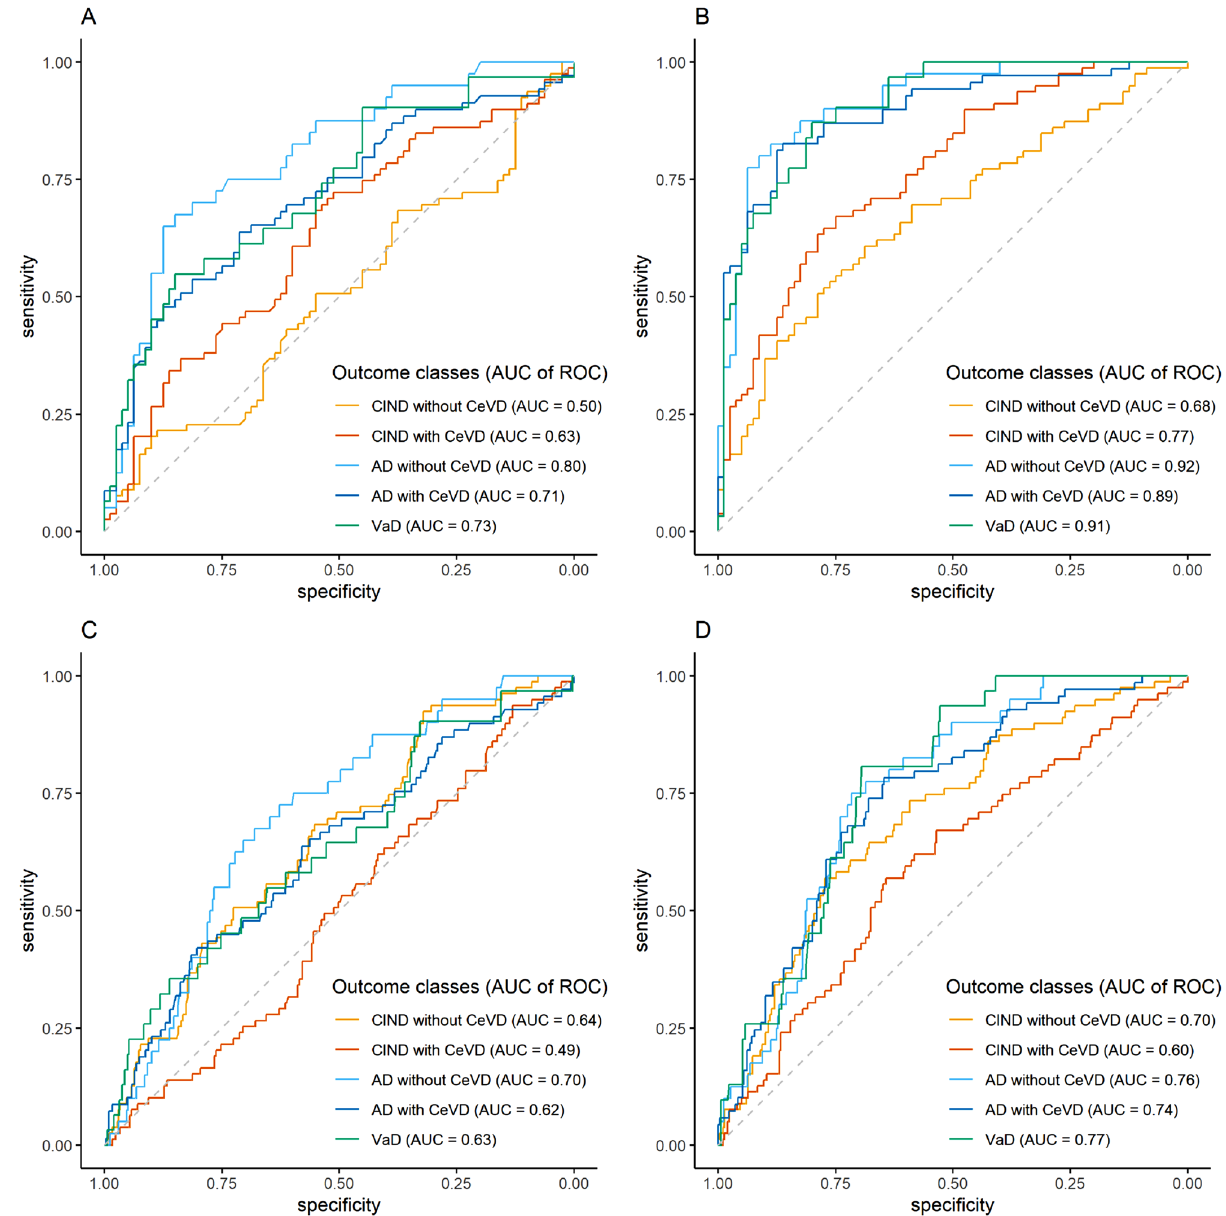
Figure 1. ROC curves of plasma OPN for discriminating each diagnostic outcome from ( A , B ) NCI or from ( C , D ) all other diagnoses (n =